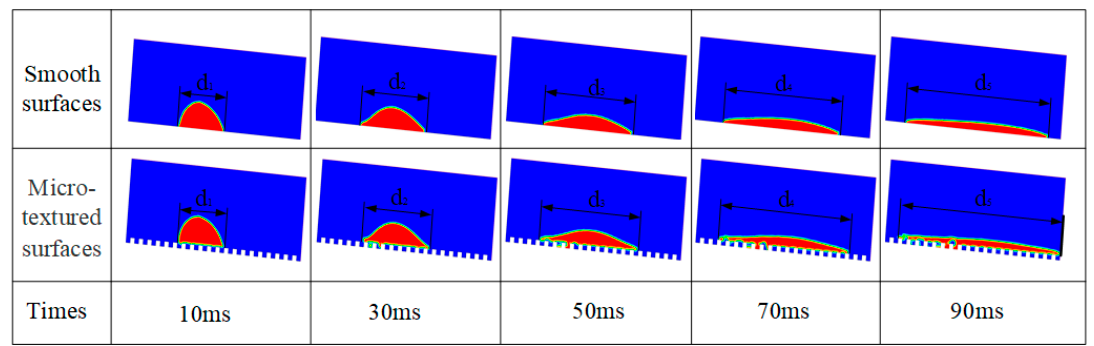
Figure 9. Motion evolution of drop on textured and smooth surfaces.